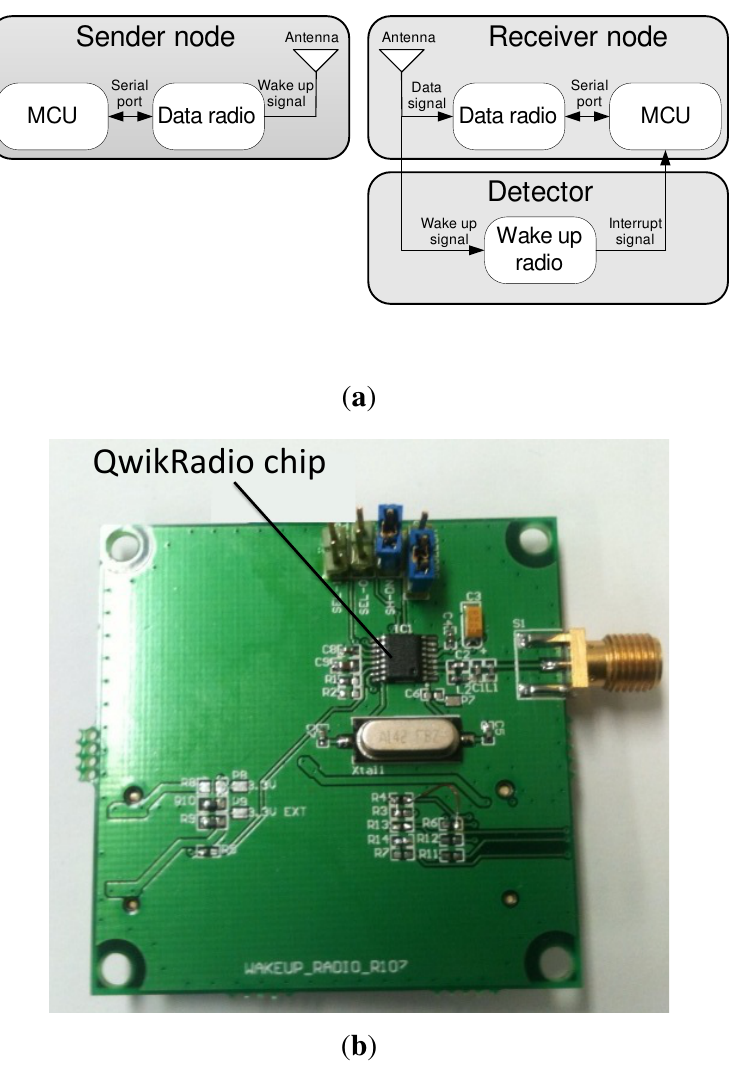
Figure 6. LDWuR prototype. ( a ) Block diagram of LDWuR and nodes; ( b ) circuit